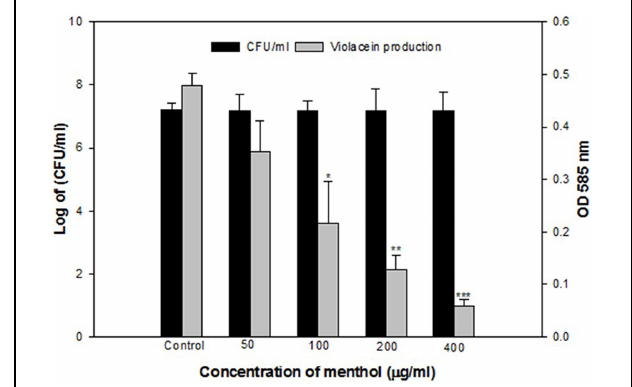
FIGURE 3 | Quantitative assessment of violacein inhibition in CVO26 by sub-MICs of menthol. All of the data are presented as mean ± SD. Significance at ∗ p ≤ 0.05, significance at ∗∗ p ≤ 0.005, significance at ∗∗∗ p ≤